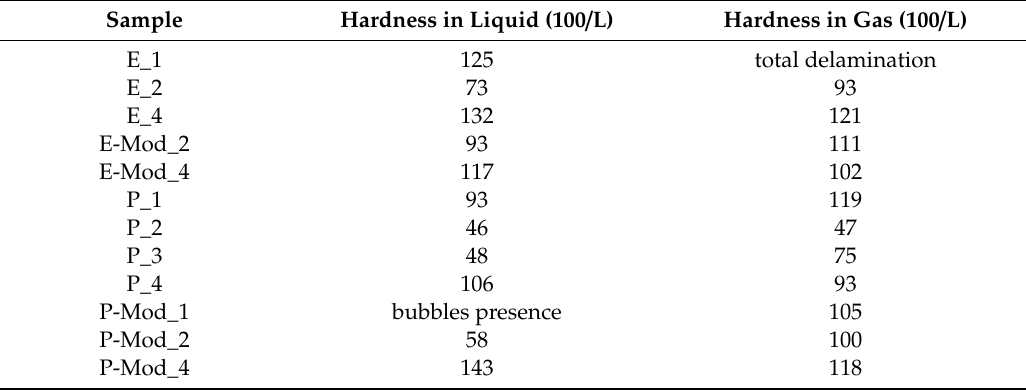
Table 5. Buchholz hardness measurements related to the samples that do not shows coatings delamination or